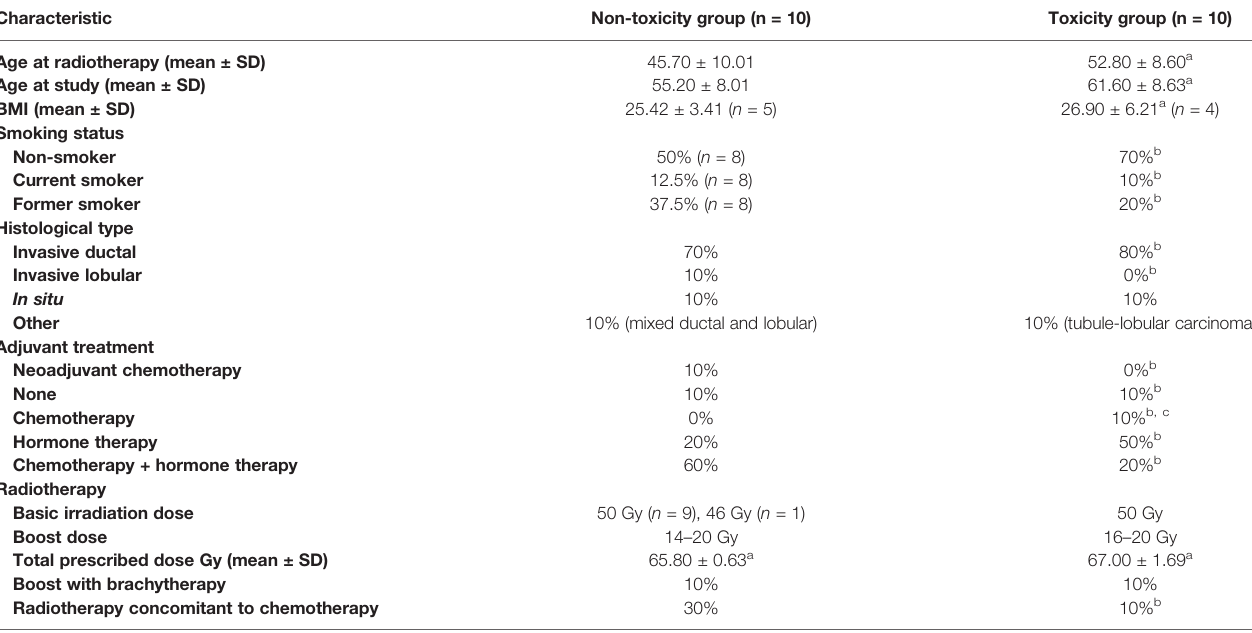
TABLE 2 | Clinical and demographic characteristics of the analyzed patients [adapted from